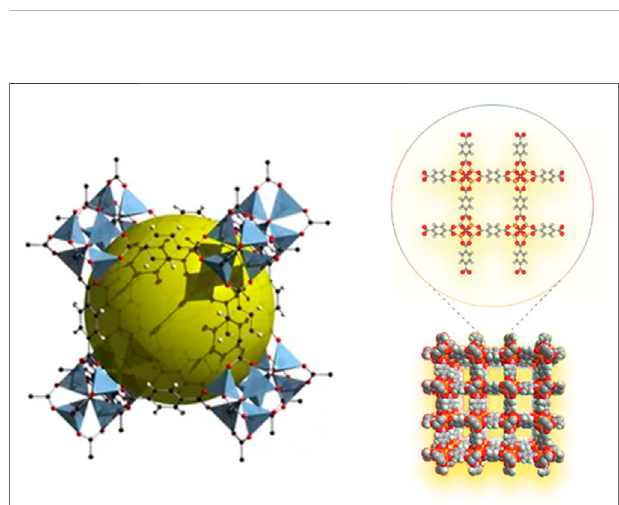
FIGURE 4 | MOF-5 three-dimensional structure diagram (Li et al., 1999; Xie et al., 2022).